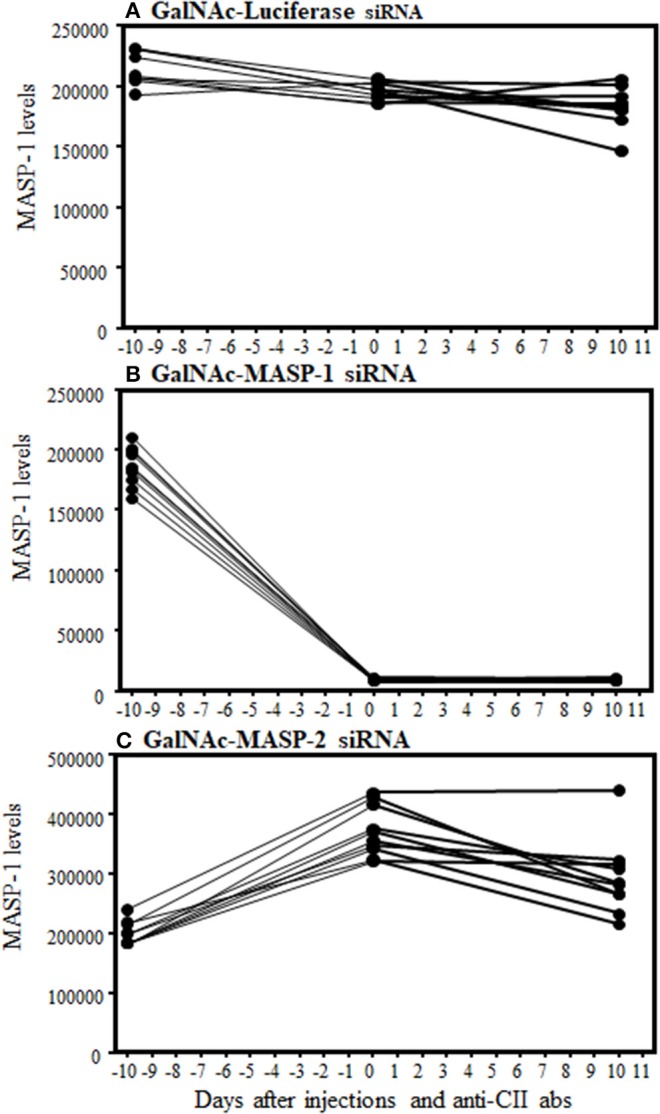
Time-resolved immunoflorometric assay for MASP-1 levels showing a decrease in the absolute levels of MASP-1 protein in the circulation of mice arthritic injected with GalNAc-MASP-1-siRNA. Sera were diluted 1:75 from arthritic mice treated with GalNAc-Luciferase-siRNA, GalNAc-MASP-1-siRNA and GalNAc-MASP-2-siRNA and levels of MASP-1 were examined by ELISA. (A) No change in MASP-1 levels at day −10, 0 and at day +10 treated with control GalNAc-Luciferase-siRNA. (B) A substantial decrease in the levels of MASP-1 at day 0 and at day +10 vs. −10 in the circulation of mice treated with GalNAc-MASP-1-siRNA. (C) No decrease in the levels of MASP-1 at day 0 and at day +10 vs. −10 in the circulation of mice treated with GalNAc-MASP-1-siRNA. Data from all mice (n = 30) have been shown. p < 0.05 at day 0 and at day +10 vs. at −10 mice injected with GalNAc-Luciferase-siRNA (n = 10) or GalNAc-MASP-1-siRNA (n = 10) or GalNAc-MASP-2-siRNA (n = 10).